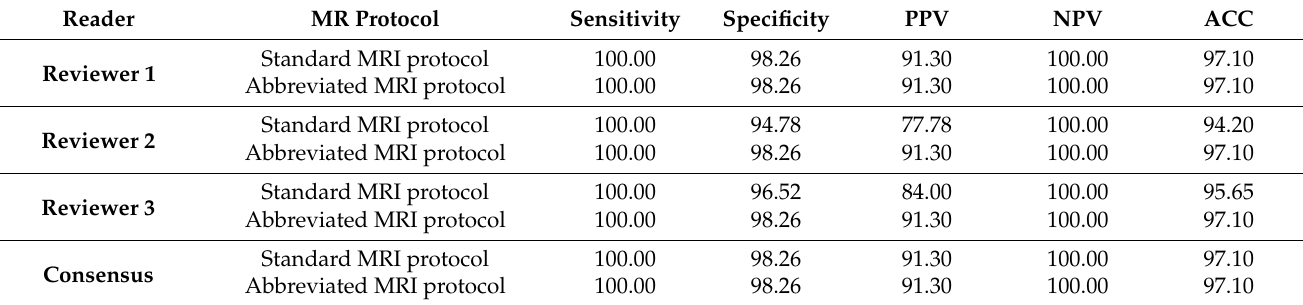
Table 3. Diagnostic performance for each reader and for consensus